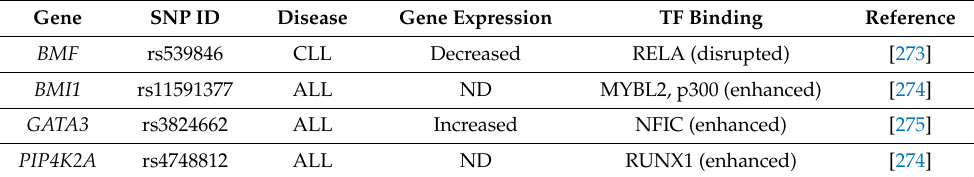
Table 5. Germline variants in enhancer regions associated with B-cell